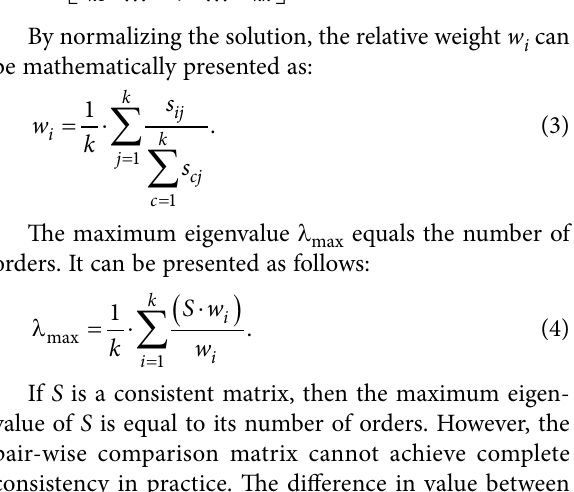
Figure 2. Structure for analysing the values of similar units